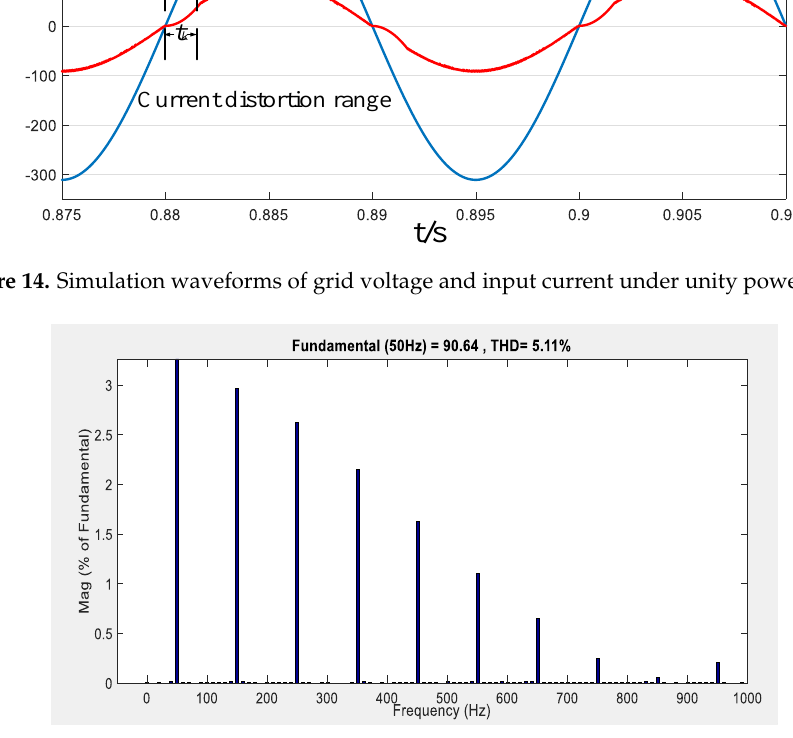
Figure 15. THD analysis of input current under unity power factor.